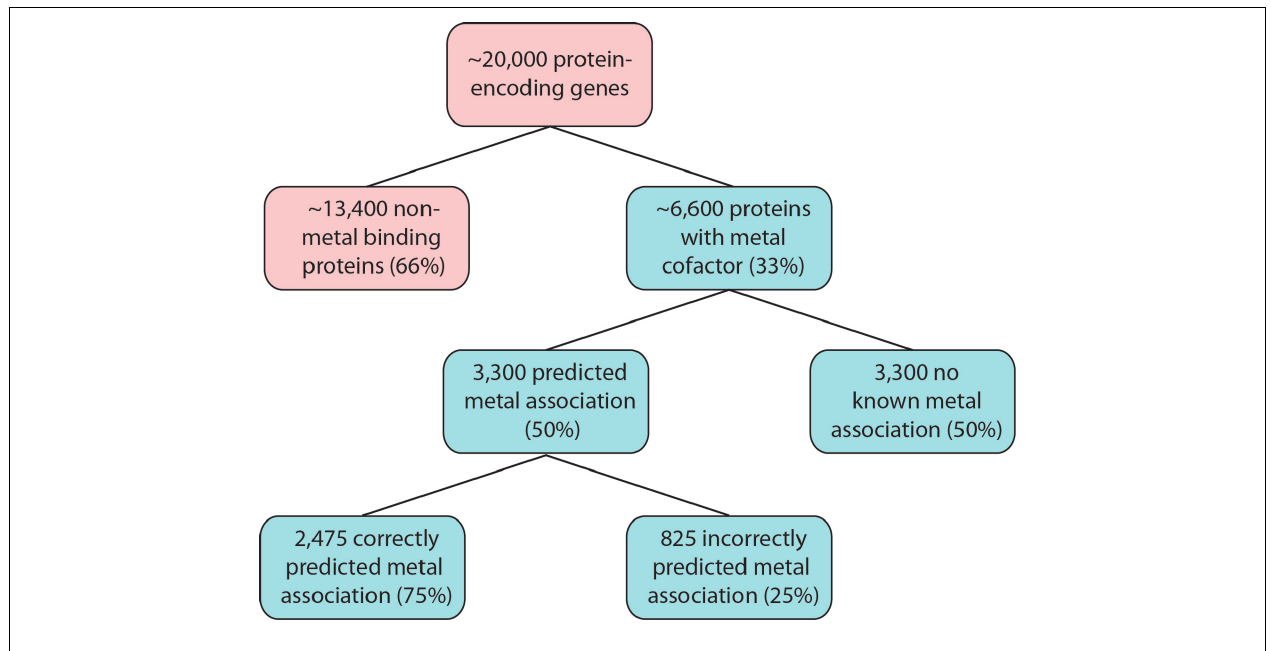
FIGURE 1 | Estimated size of the metalloproteome. Following the example of P. furiosus , as many as 6,600 human proteins are estimated to have metal association. Our limited knowledge of metalloproteins, combined with